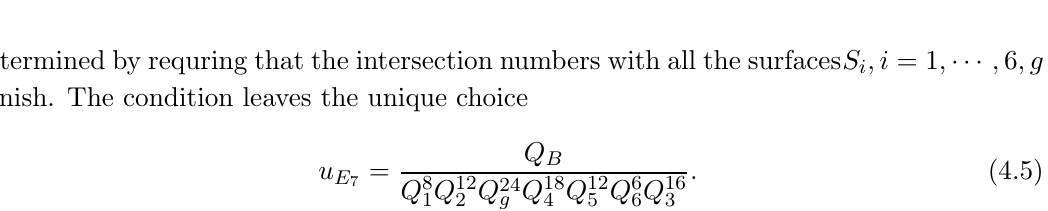
Table 5 . The matrix of the intersection numbers between the divisors S i ; i = 1 ; curves C i ; i = 1 ; ; 6 ; g; B (cid:1) (cid:1) (cid:1)